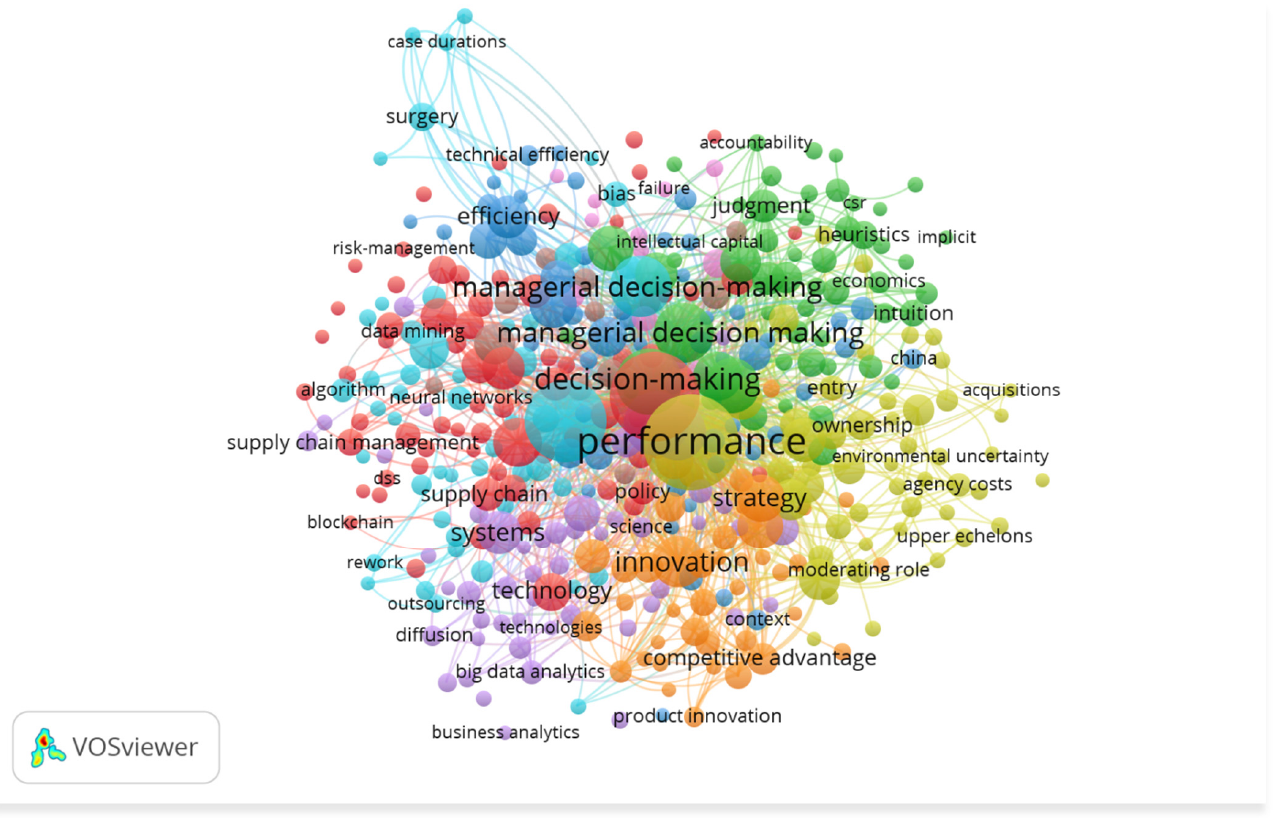
Figure 3. MD: Keyword’s co-occurrence network-related publications—by VOSviewer (392 items meeting threshold of 5 occurrences of keywords) (Source: authors’ own research).